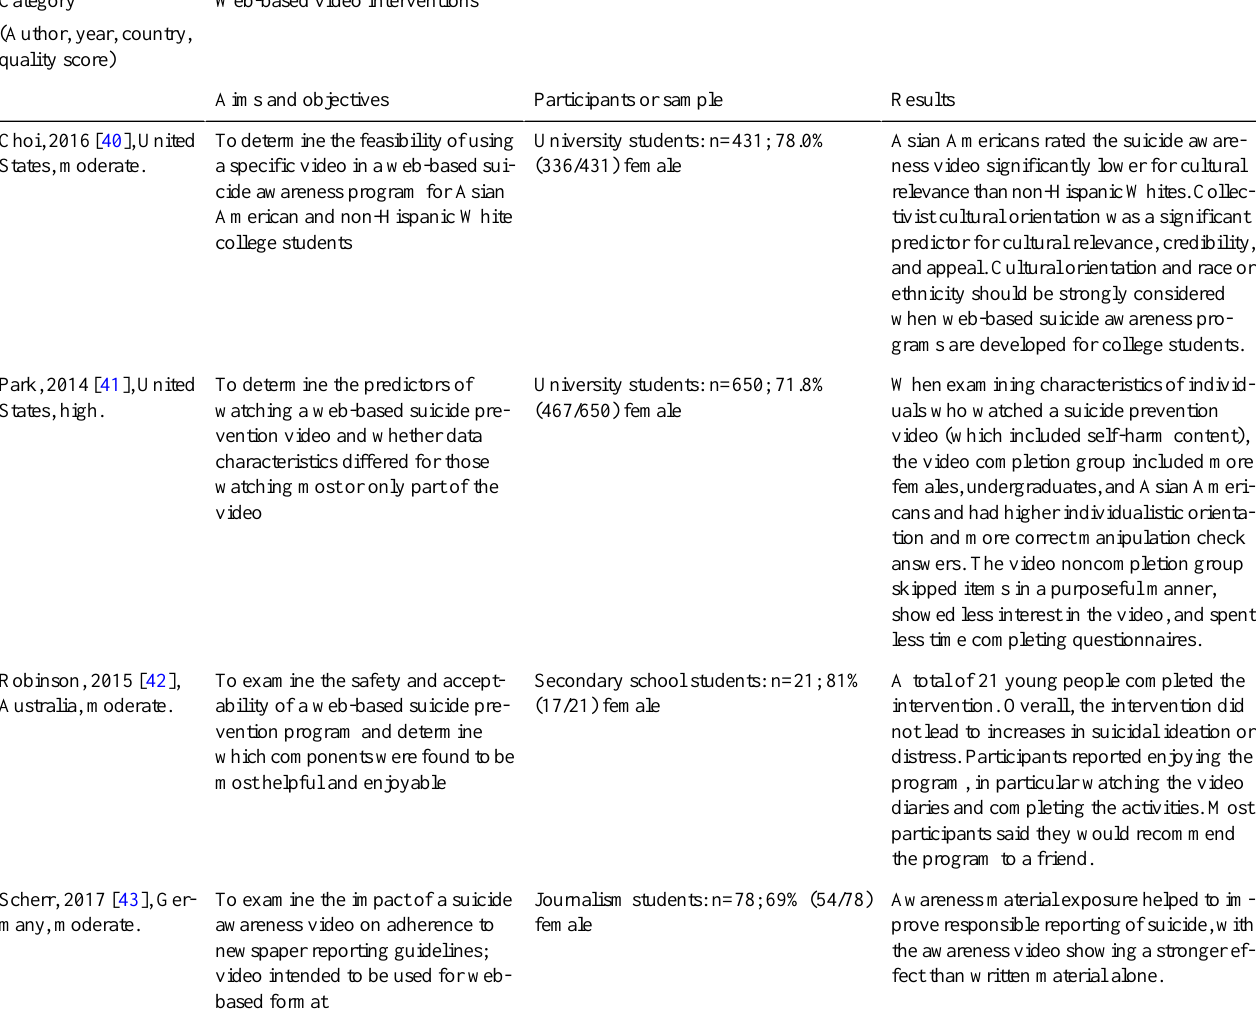
Table 3. Summary of included studies examining web-based interventions using videos. Web-based video